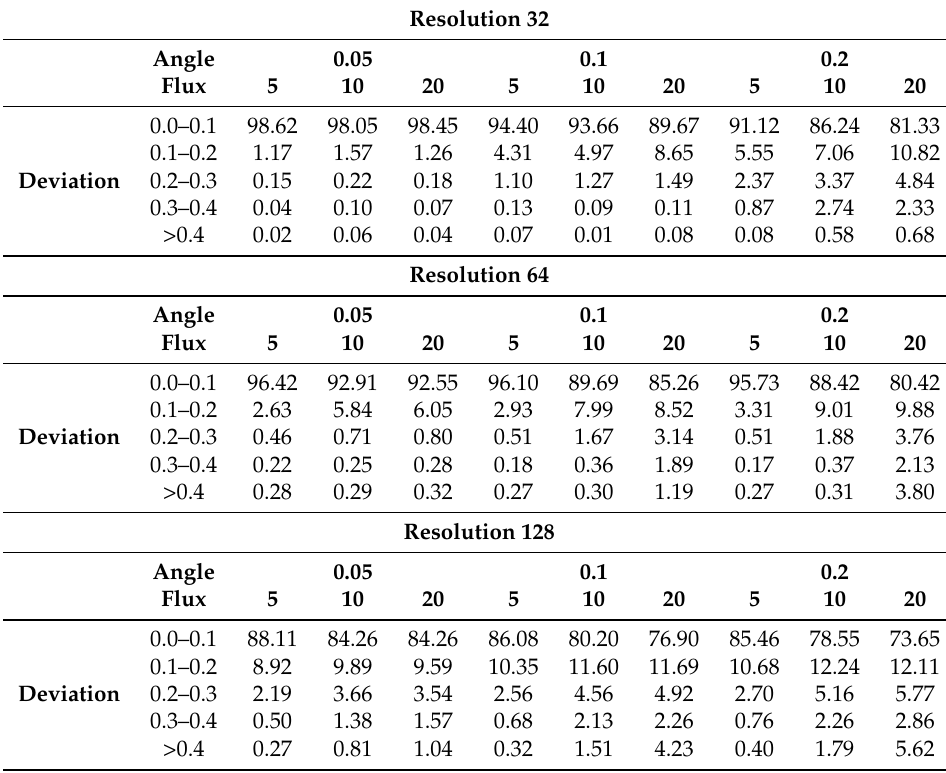
Table 4. Distribution of surface deviations (normalized to the cell size) at T ≈ 1.0 for different level-set resolutions, normal angle, and flux thresholds. The population of the bins is given in